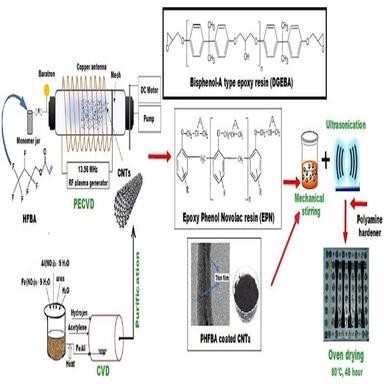
Schematic showing of CNT synthesis, coating by PECVD and the preparation of CNTs composites.